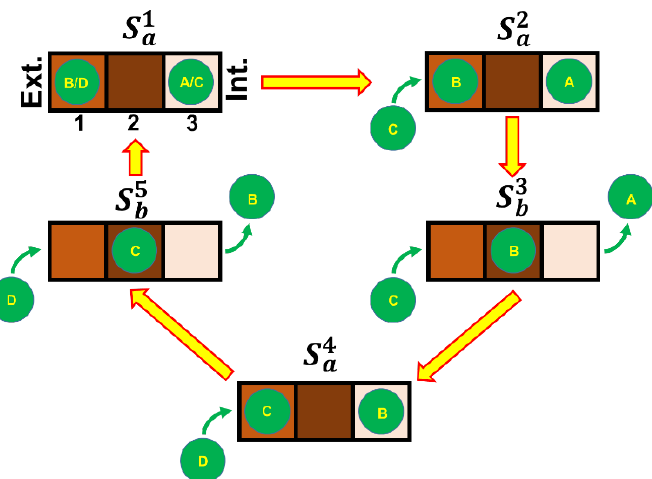
Figure 8. Five “screenshots” of unidirectional Ca 2+ permeation along the channel selectivity filter. The sequence starts from the screenshot 1 ( 𝑆 𝑎1 ), outlining the channel selectivity filter, that, for the sake of simplicity, depicts it in the S a state, i.e., with a Ca 2+ ion (green circle, named ( B , D )) bound in Site 1 (facing the extracellular side, Ext.) and a second Ca 2+ ion (( A , C )) bound in Site 3 (Int.). The sequence proceeds with a Ca 2+ ion ( C ) reaching the extracellular channel vestibule ( 𝑆 𝑎2 ), and the electrostatic repulsion with ion ( B ) and the higher affinity of Site 2 move ion ( B ) to Site 2, which in turn pushes ion ( A ) to move into the cytosol (again due to electrostatic repulsion between ( A , B )), returning the selectivity filter to state S b ( 𝑆 𝑏3 ). The binding of ion ( C ) to Site 1 pushes ion ( B ) toward Site 3, switching the filter in state S a ( 𝑆 𝑎4 ). A fourth ion ( D ) reaching the external channel vestibule pushes the ion ( C ) to Site 2, which in turn pushes ion ( B ) to exit the channel, switching the filter in state S b ( 𝑆 𝑏5 ). Finally, ion ( D ) binds to Site 1, pushes ion ( C ) to Site 3, the filter returns to state S a , and the cycle repeats.